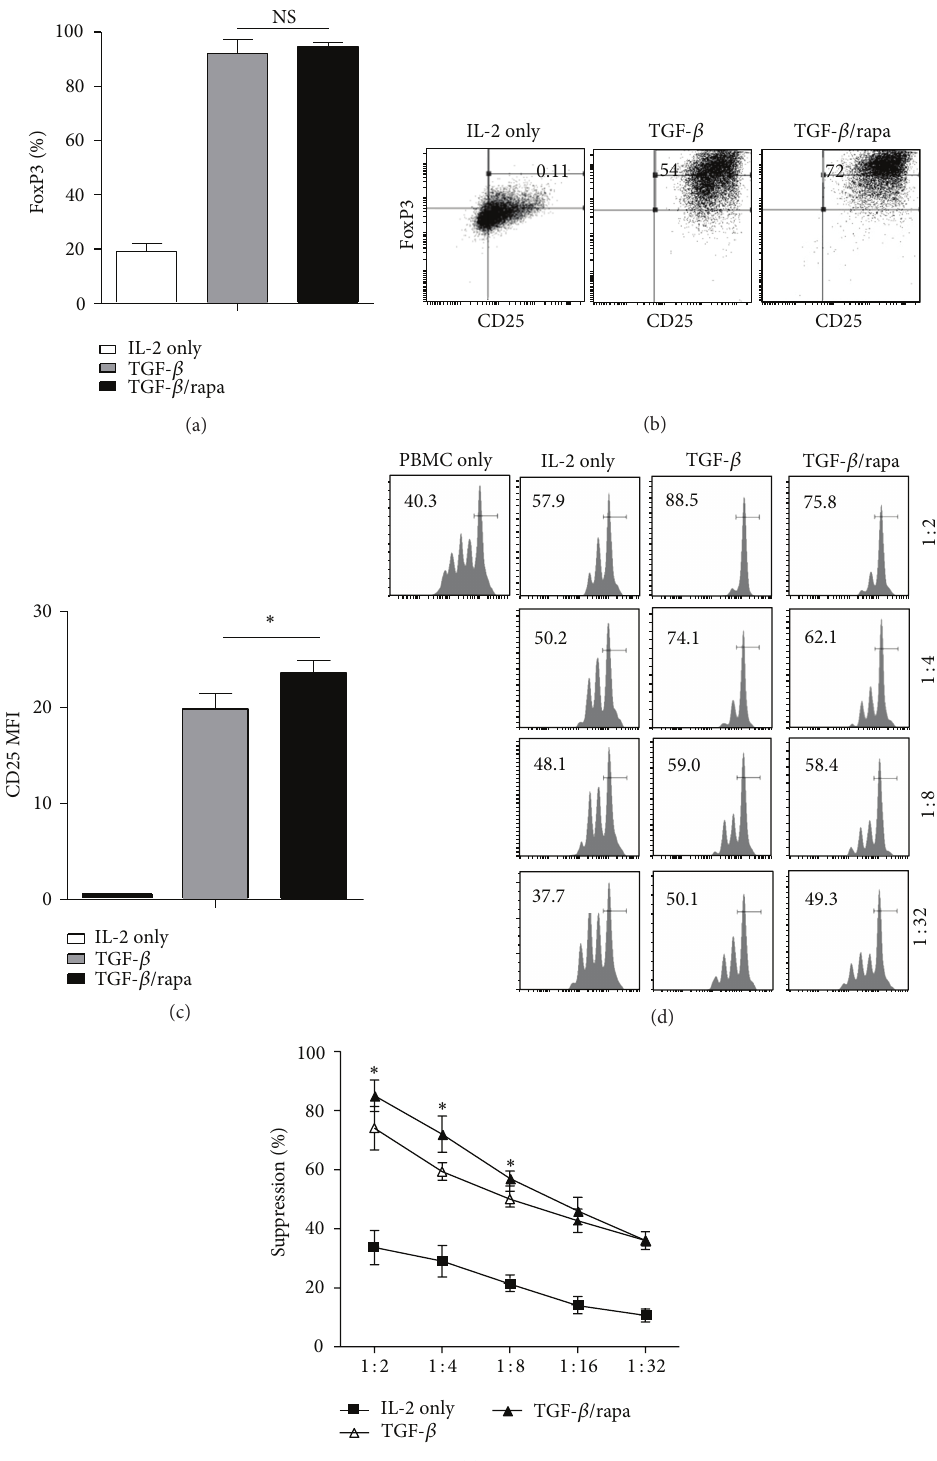
Figure 2: Rapamycin improved the expression of FoxP3 and developed the potent suppressive activity in vitro . (a) The proportion of CD4 + CD25 + FoxP3 + iTreg induced from na¨ıve T cells. (b) CD25 and FoxP3 coexpression in iTreg was assessed by flow cytometry on day 7. (c) Relative CD25 MFI in iTreg cells on day 7 with or without rapamycin. (d) In this representative experiment, the cells were stained for anti-CD8 and the suppressive activity of various primed CD4 + cells subsets on CFSE-labeled CD8 + at various T suppressor to T effector ratios was shown. (e) The mean ± SEM percent suppression of iTreg at the various ratios. The values indicated the mean ± SEM of 3 separate experiments. ∗ 𝑃 < 0.05